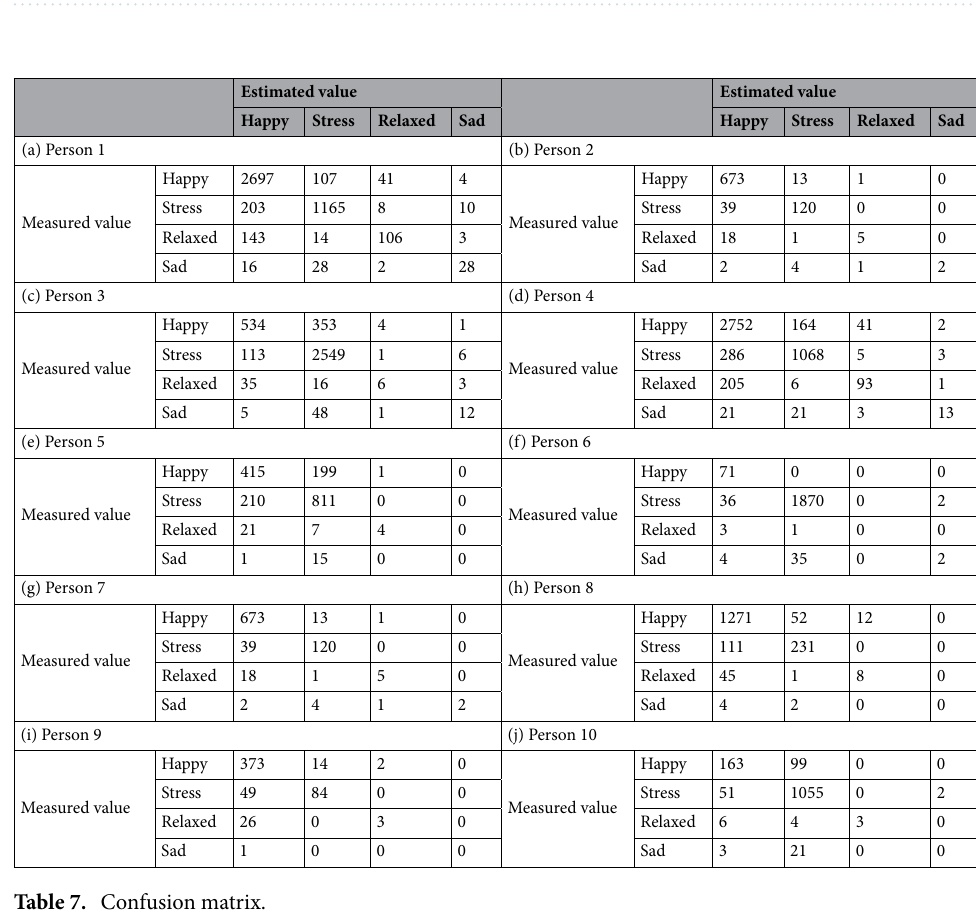
Table 6. Ratio of each emotion and estimation correspondence of a person.